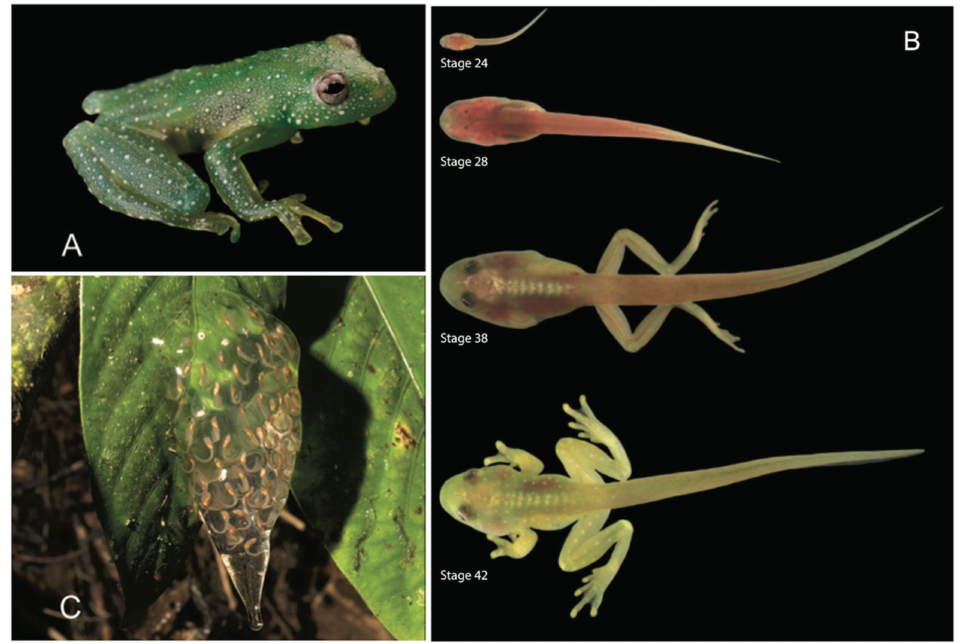
Figure 79. Life cycle in Cochranella resplendens . ( A ) Juvenile, QCAZ 38088. ( B ) Ontogenetic variation of tadpoles. ( C ) Egg clutch. Photos by Luis A. Coloma. Figure modified from Ter á n-Valdez et al. [167]. Tadpole (Figures 79 and 80): At R í o Napinaza, a clutch with 74 embryos was found on the